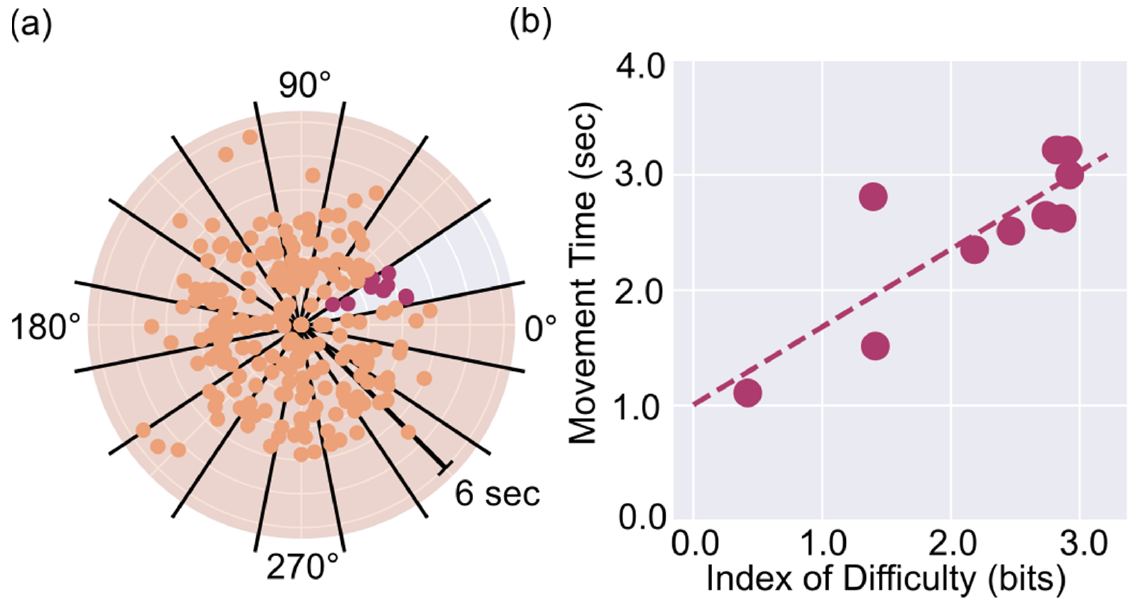
Figure 1. Example target selection data from movement characterization task. ( a ) Movement time shown as a function of target selection angle, split into 16 angular ranges (black lines). One section is highlighted with pink dots to highlight data collected within a single angular range. ( b ) Example regression of movement time against index of difficulty (bits) from the highlighted data taken in ( a ) to obtain Fitts’ Law constants.